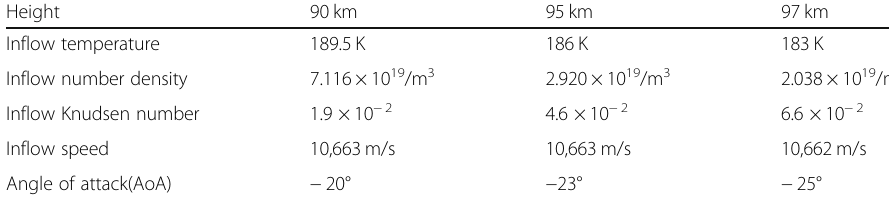
Table 6 Typical related parameters of the lunar exploration type capsule for the first reentry